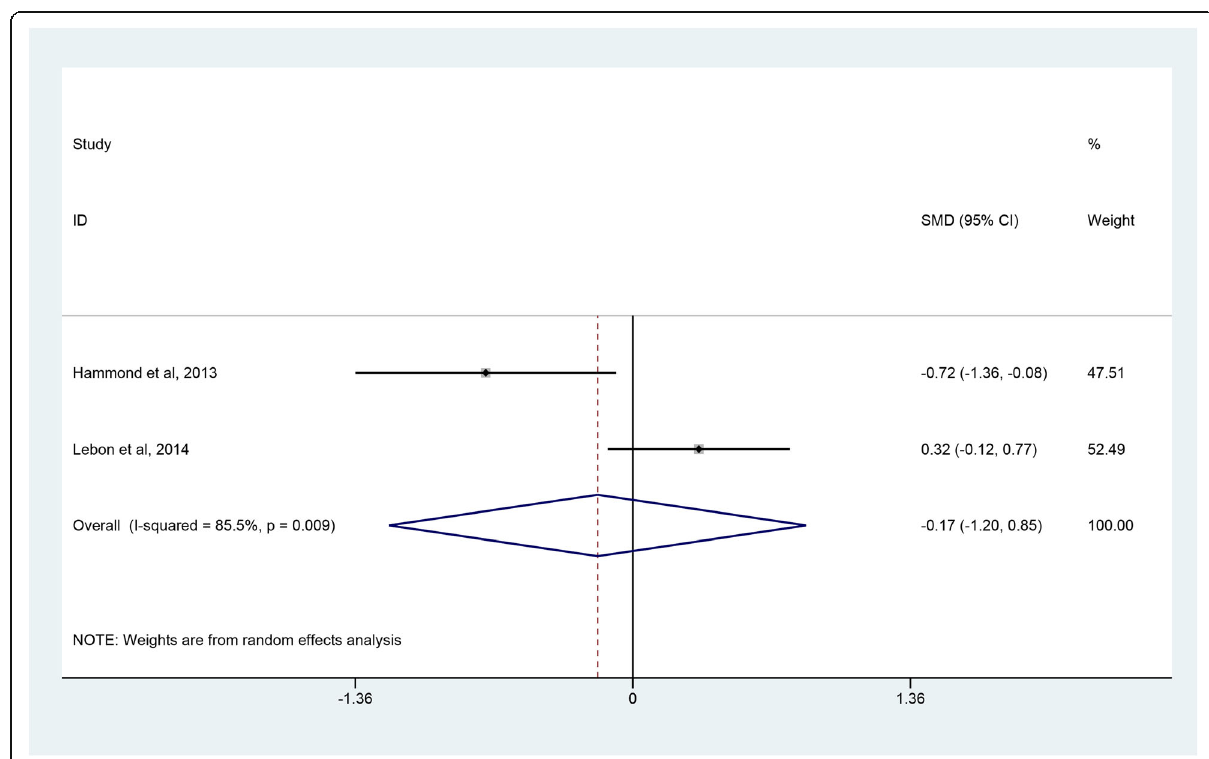
Fig. 8 Forest plot comparing the external rotation after resurfacing hemiarthroplasty (RHA) versus stemmed hemiarthroplasty